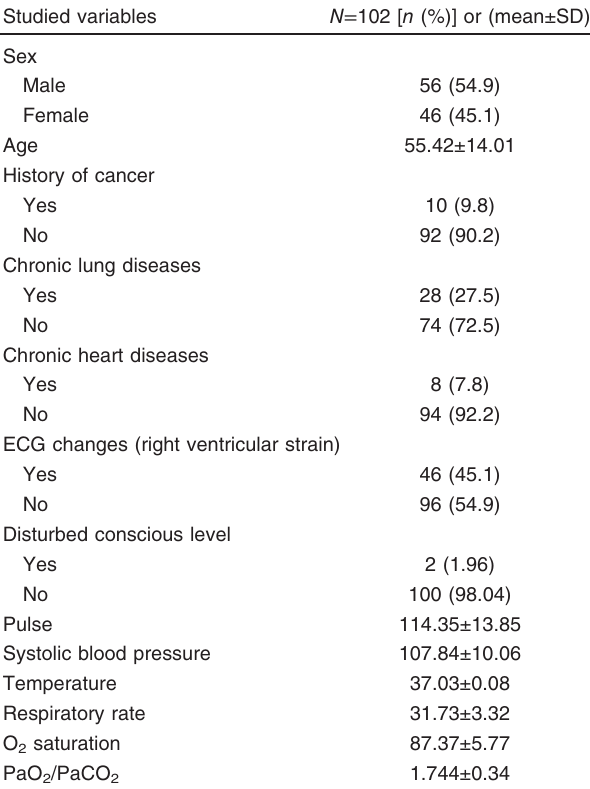
Table 2 Patient characteristics used to calculate the studied scores Studied